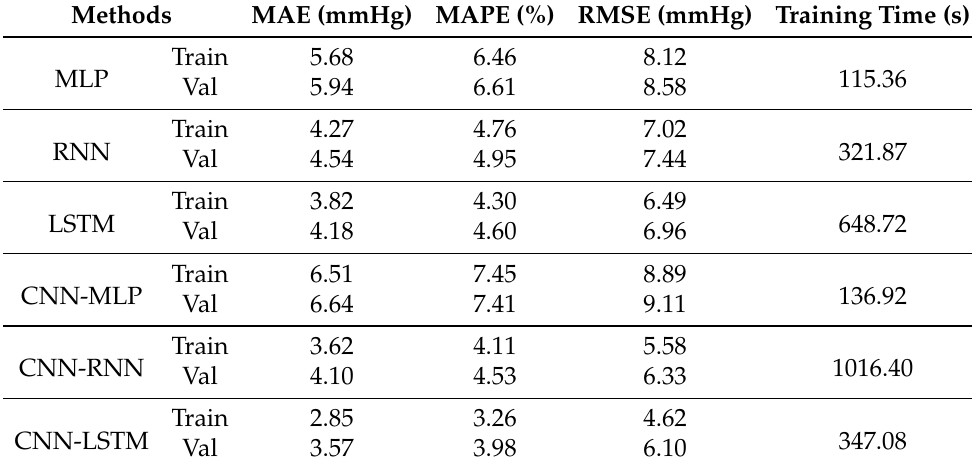
Table 4. Predicted performance of patient 39.